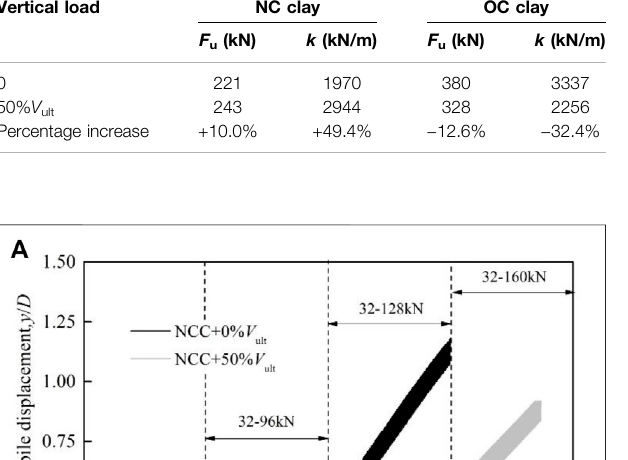
FIGURE 4 | Measured monotonic load-displacement relationships of the pile.